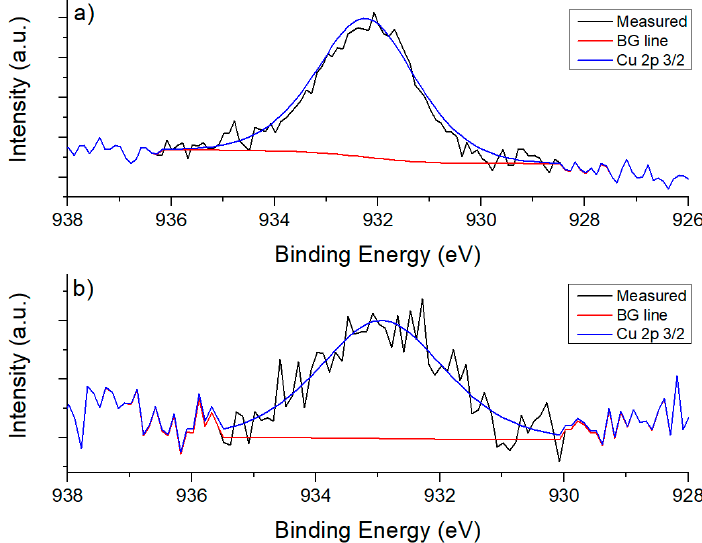
Figure 7. Cu 2p 3/2 components for catalysts: ( a ) IrCu/CeO 2 , ( b ) IrCu/La 2 O 3 .